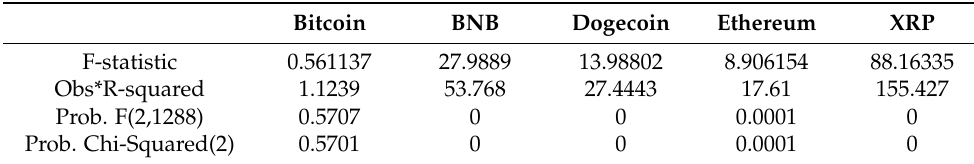
Table 4. Heteroskedasticity Test: ARCH of